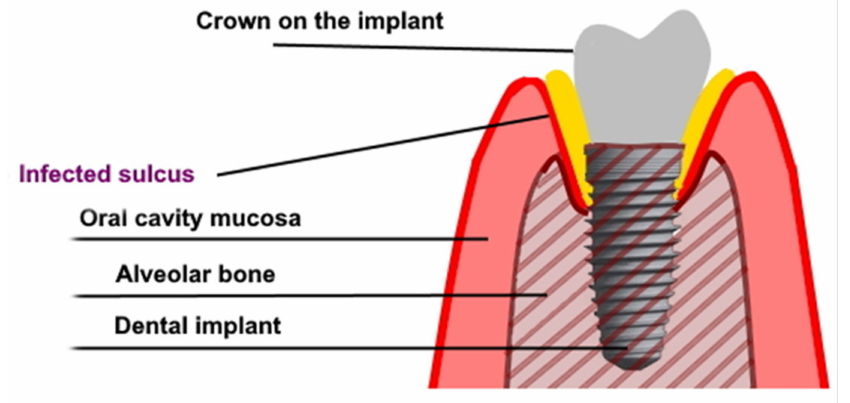
Figure 1. The graph shows